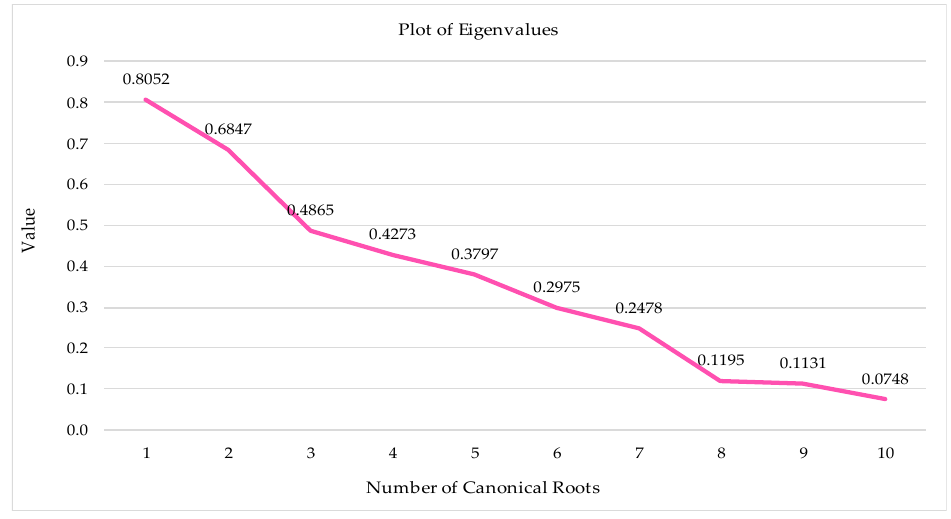
Figure 1. Graph of eigenvalues.